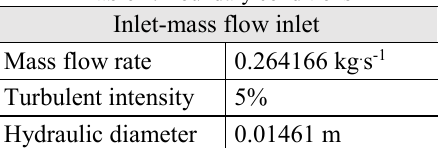
Table 2. Boundary conditions